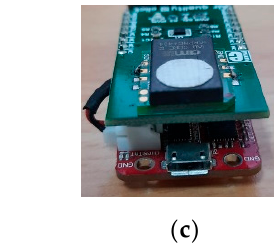
Figure 6. VOCs sensor node prototype: ( a ) side view, ( b ) energy source (supercapacitor), and ( c ) front view.